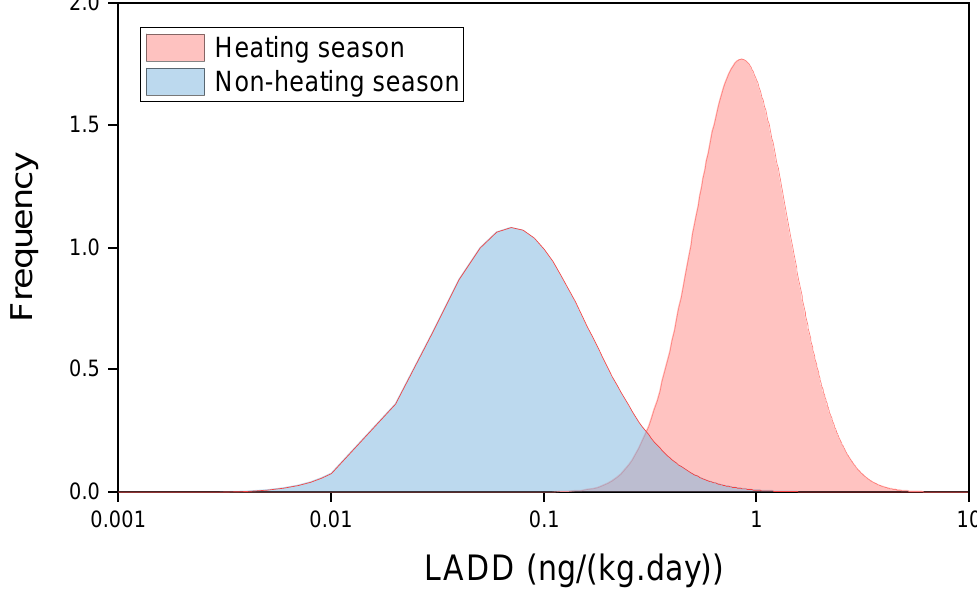
Figure 5. Individual exposure in the heating and non-heating seasons.